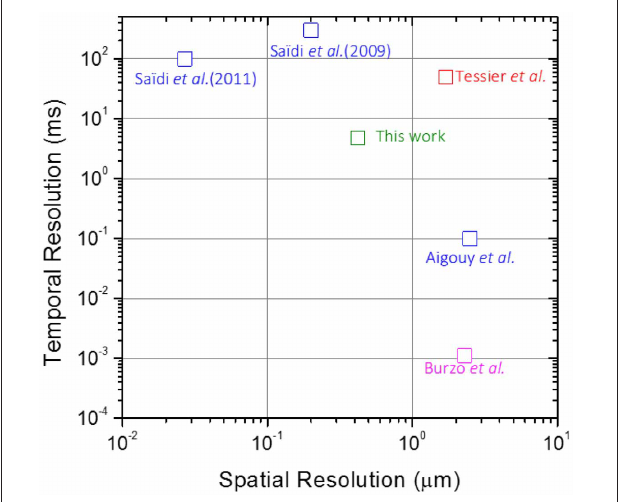
FIGURE 7 | Spatio-temporal resolution for temperature mapping of integrated circuits using distinct luminescent thermometers.